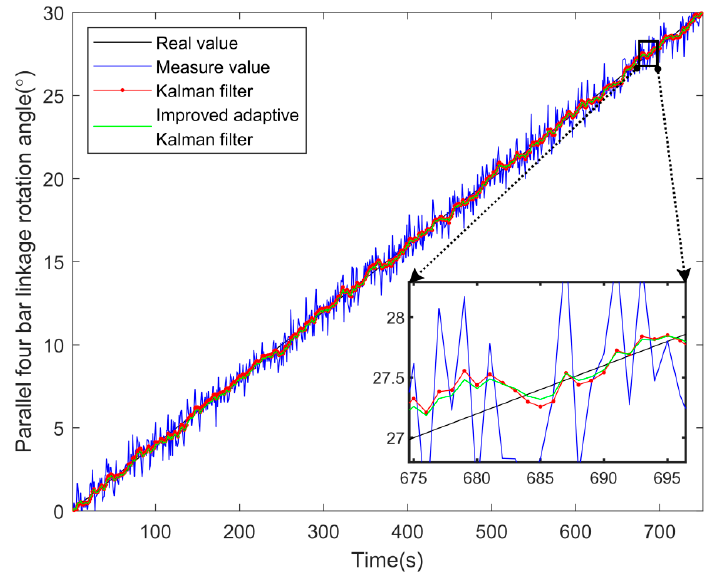
Figure 9. IAKF of the parallel four-bar linkage rotation angle